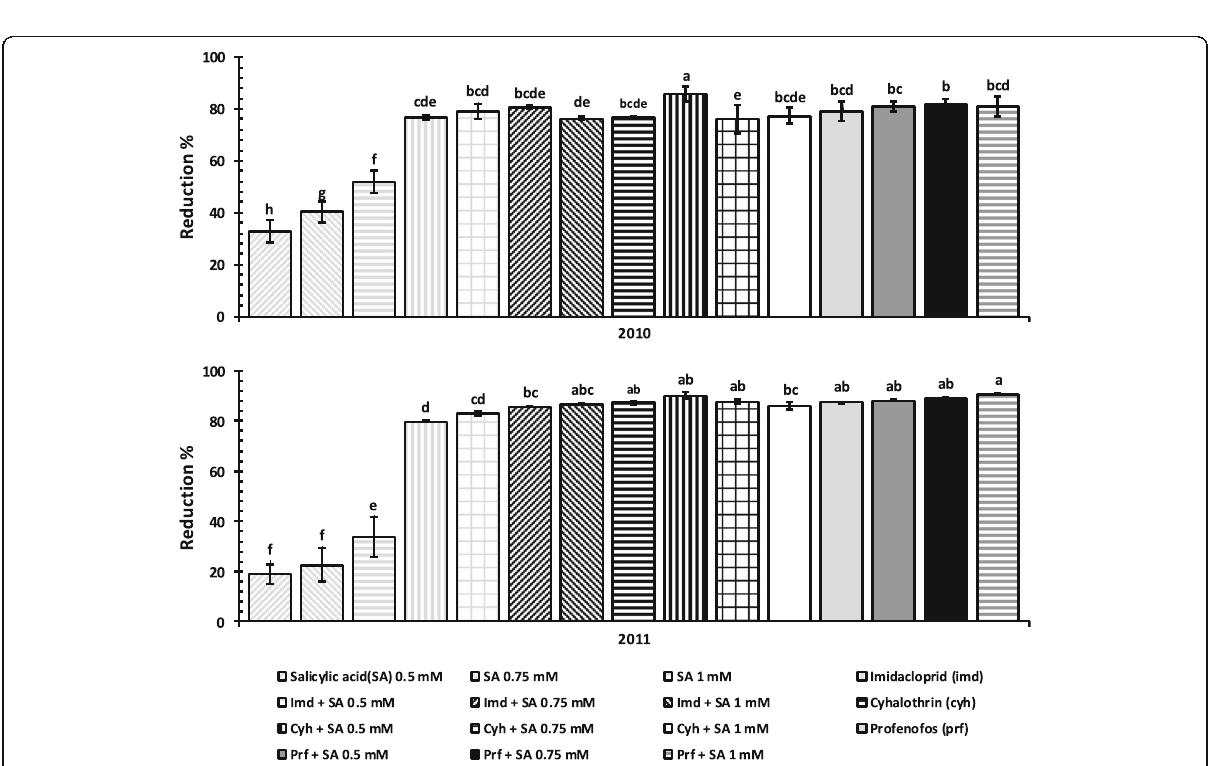
Fig. 2 Efficiency of certain insecticides and/or SA combination against the immature stage of the whiteflies B. tabaci in cotton plants